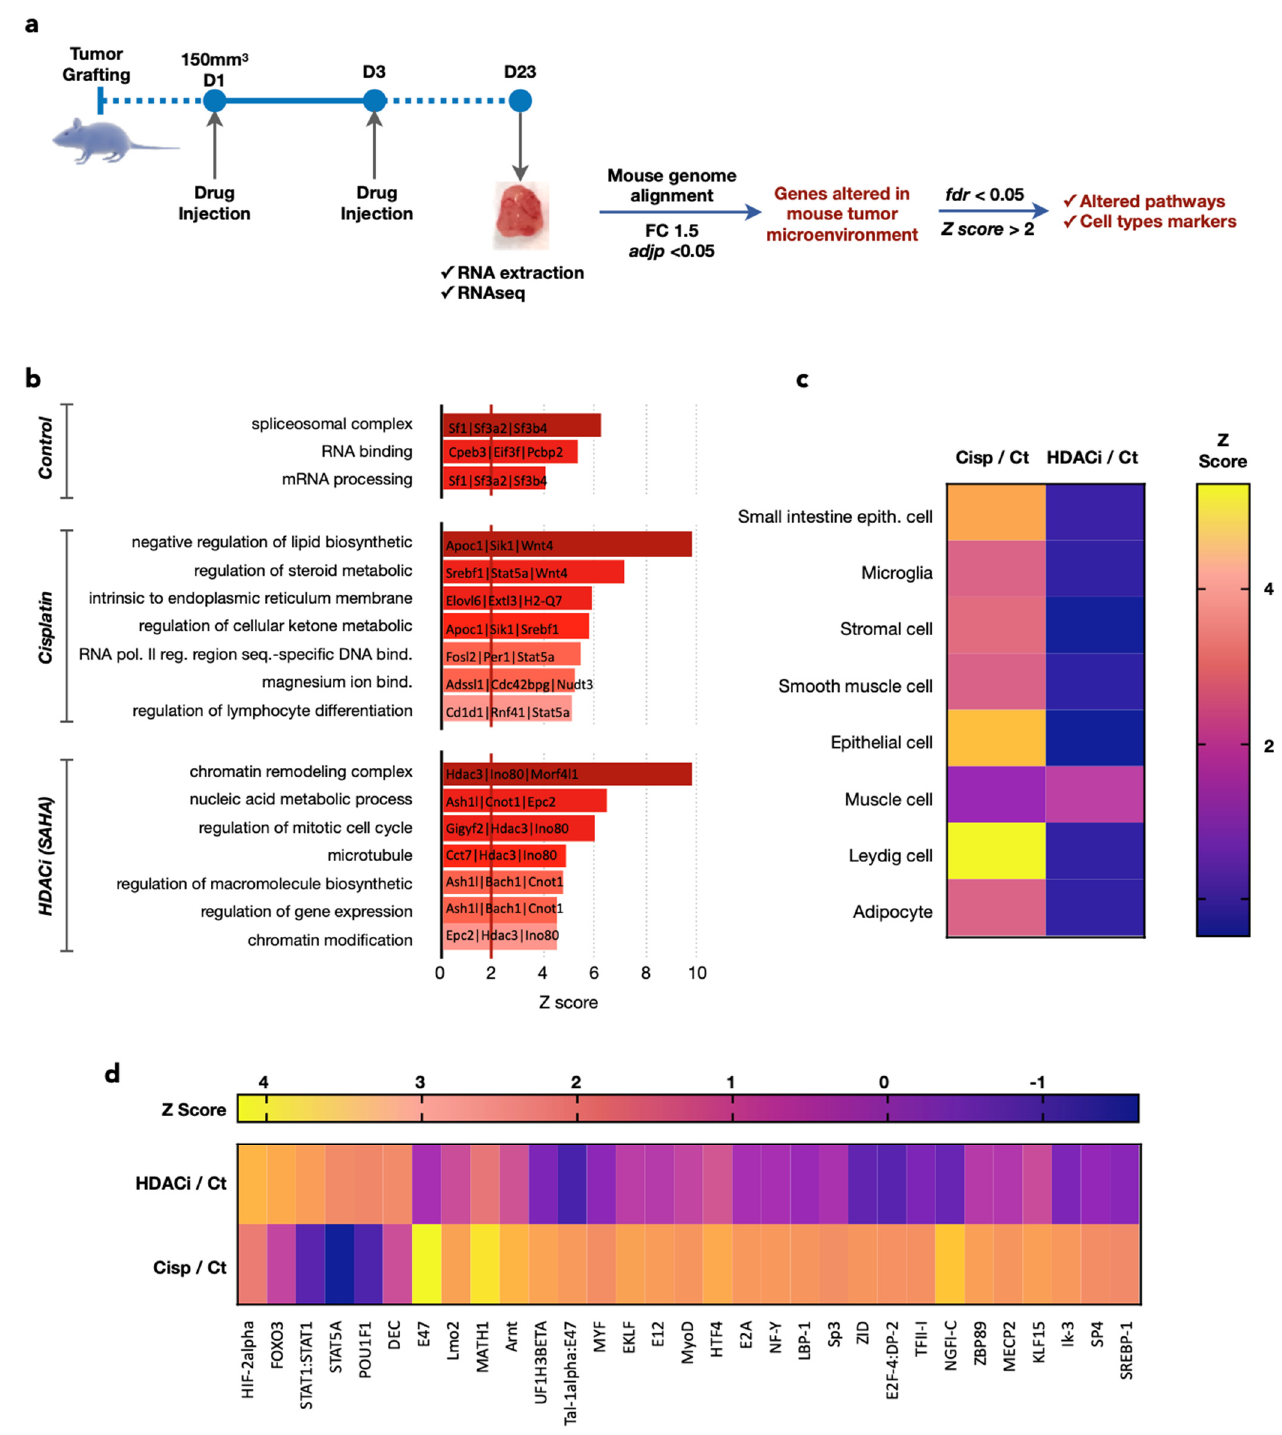
Figure 6. Transcriptomics analyses confirm differences in the mouse stroma/microenvironment of the human gastric tumor caused by cisplatin and SAHA. ( a ) Total RNAs were extracted from the tumors. Sequences obtained were specifically aligned on the mouse genome. Deregulated genes with fold change >1.5 and p -value < 0.05 were analyzed. False discovery error <0.05 and Z score above 2 were chosen as the cut-off in bioinformatics analyses and AltAnalyze was used to find gene signatures corresponding to given processes representing biomarkers selective of each condition ( b ), typical signatures for specific cell types ( c ), regulation of specific transcription factors ( d ).